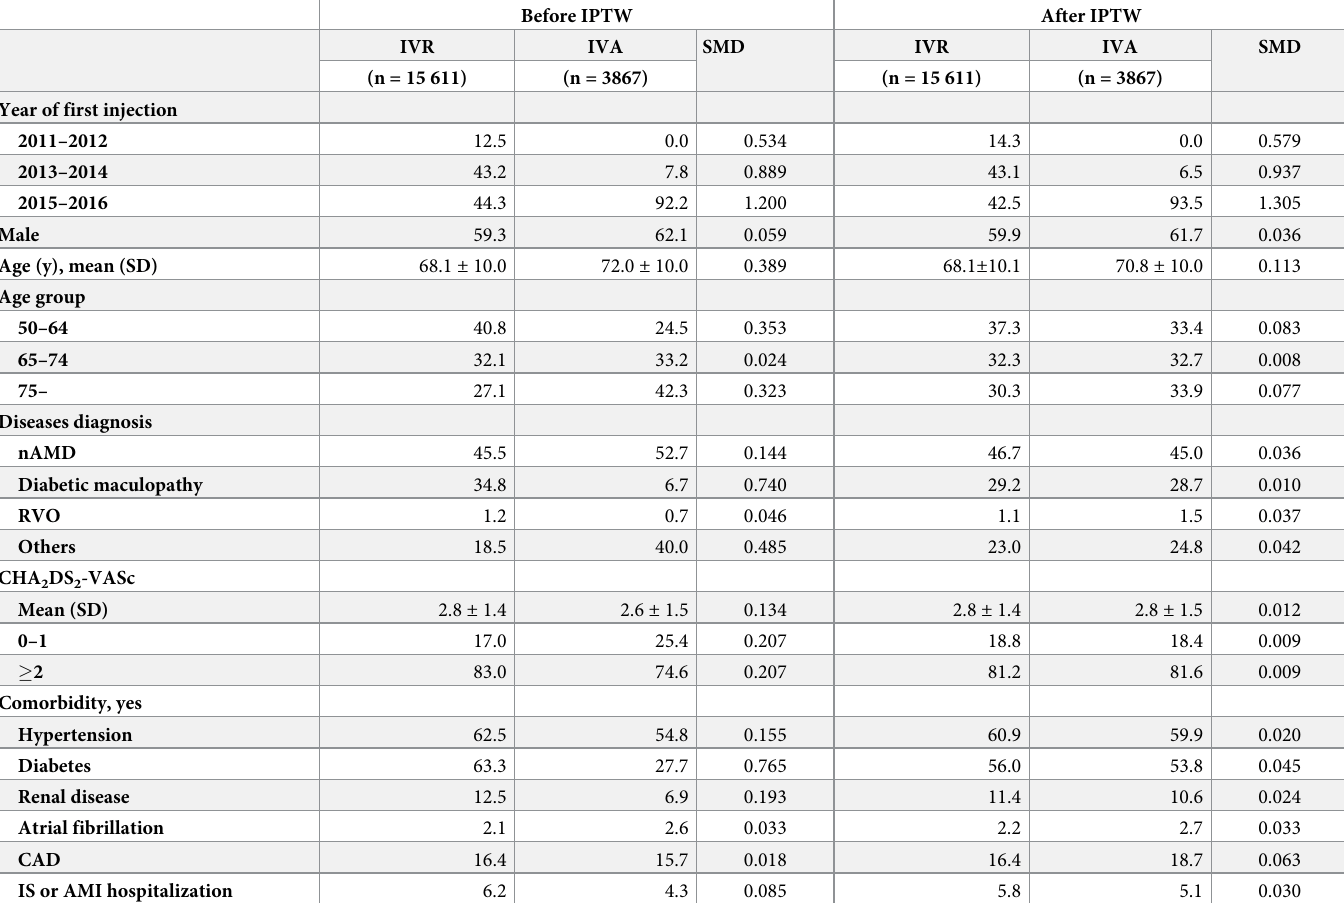
Table 1. Baseline characteristics of patients who received IVR or IVA before and After